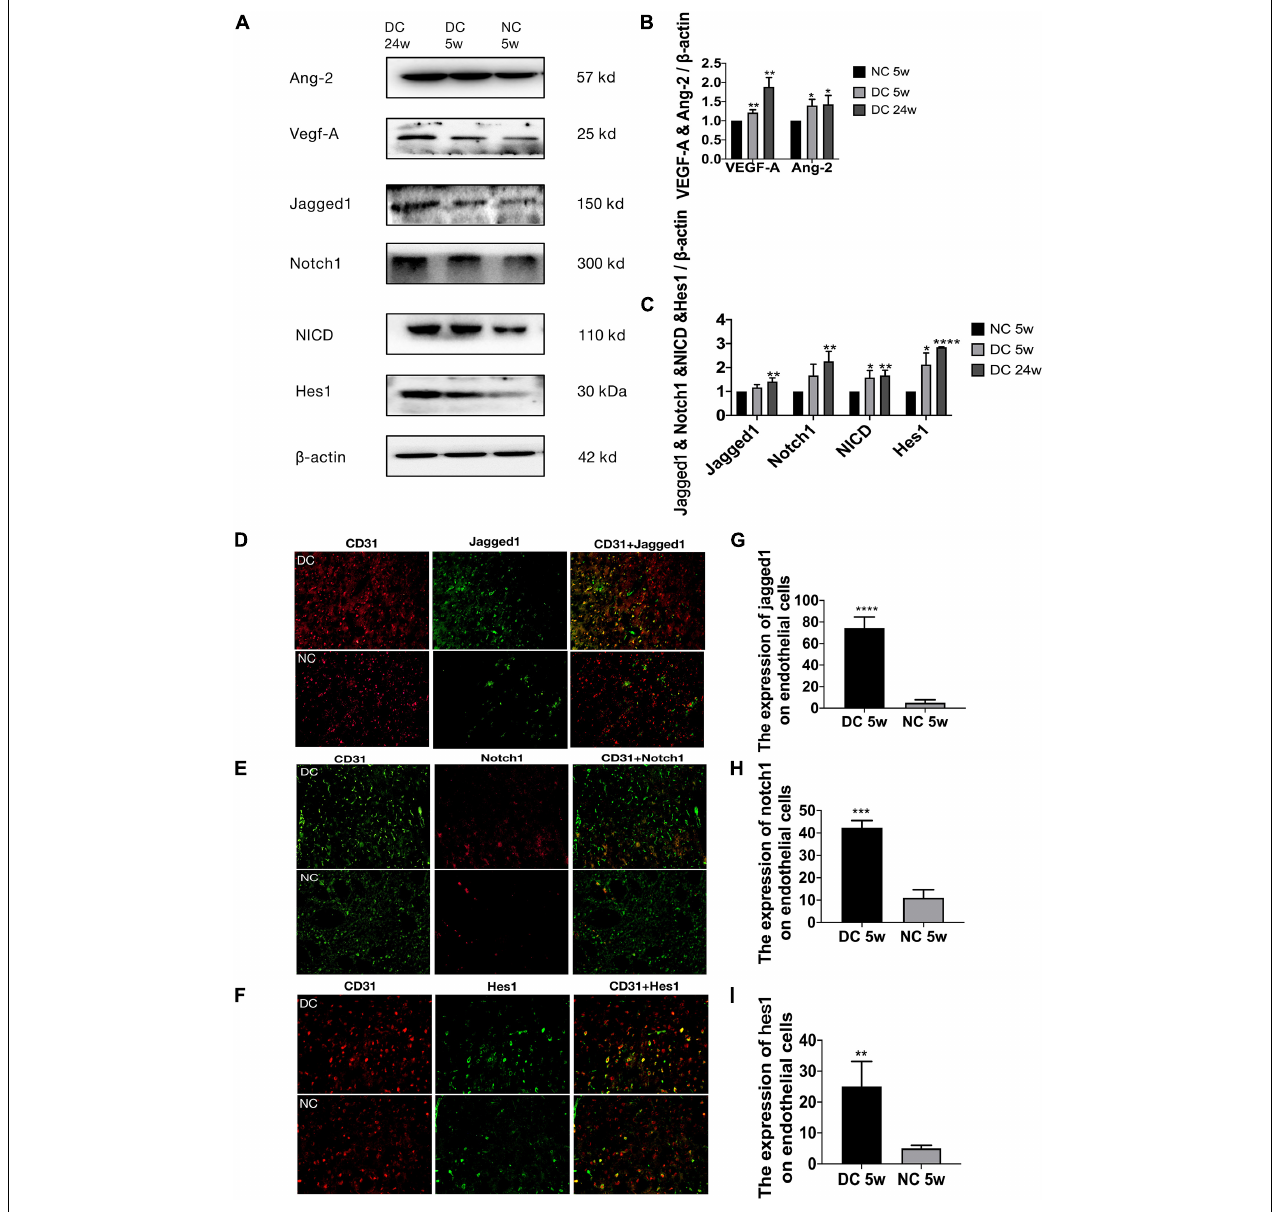
FIGURE 2 | Altered Jagged1-Notch1 signaling with baseline neovascularization in T2DM. (A–C) The expression of VEGF-A, Ang-2, Jagged1, Notch1, NICD, and Hes1 in the cortex was assessed by Western blot ( n = 3 per group). (D–I) The expression of Jagged1/Notch1/Hes1 and CD31 was assessed by immunofluorescence staining in the cortex (Magnification × 200. Scale bar = 100 µ m) and the positive cells of Jagged1/Notch1/Hes1 and CD31 were calculated ( n = 3 per group). * p < 0.05 vs. NC group, ** p < 0.01 vs. NC group, *** p < 0.001 vs. NC group, **** p < 0.0001 vs. NC